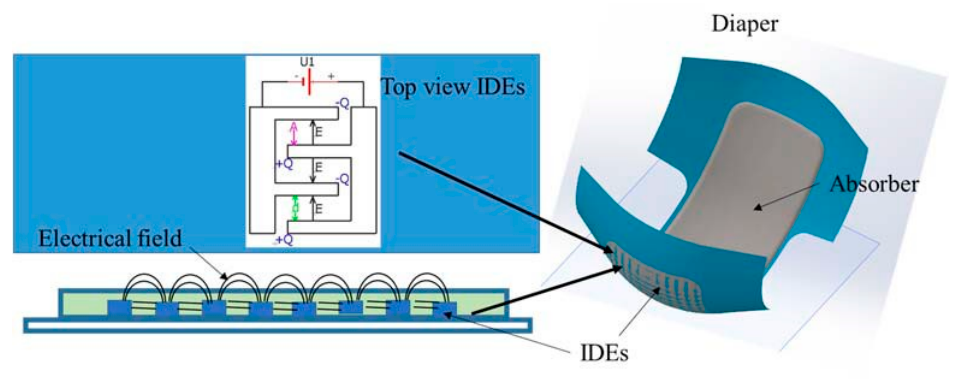
Figure 1. Sensor concept for detection of urine in incontinence materials. The sensor system is consisting of distributed single sensors integrated into diaper. The resistance and the capacitance of the sensor is depending on the amount of